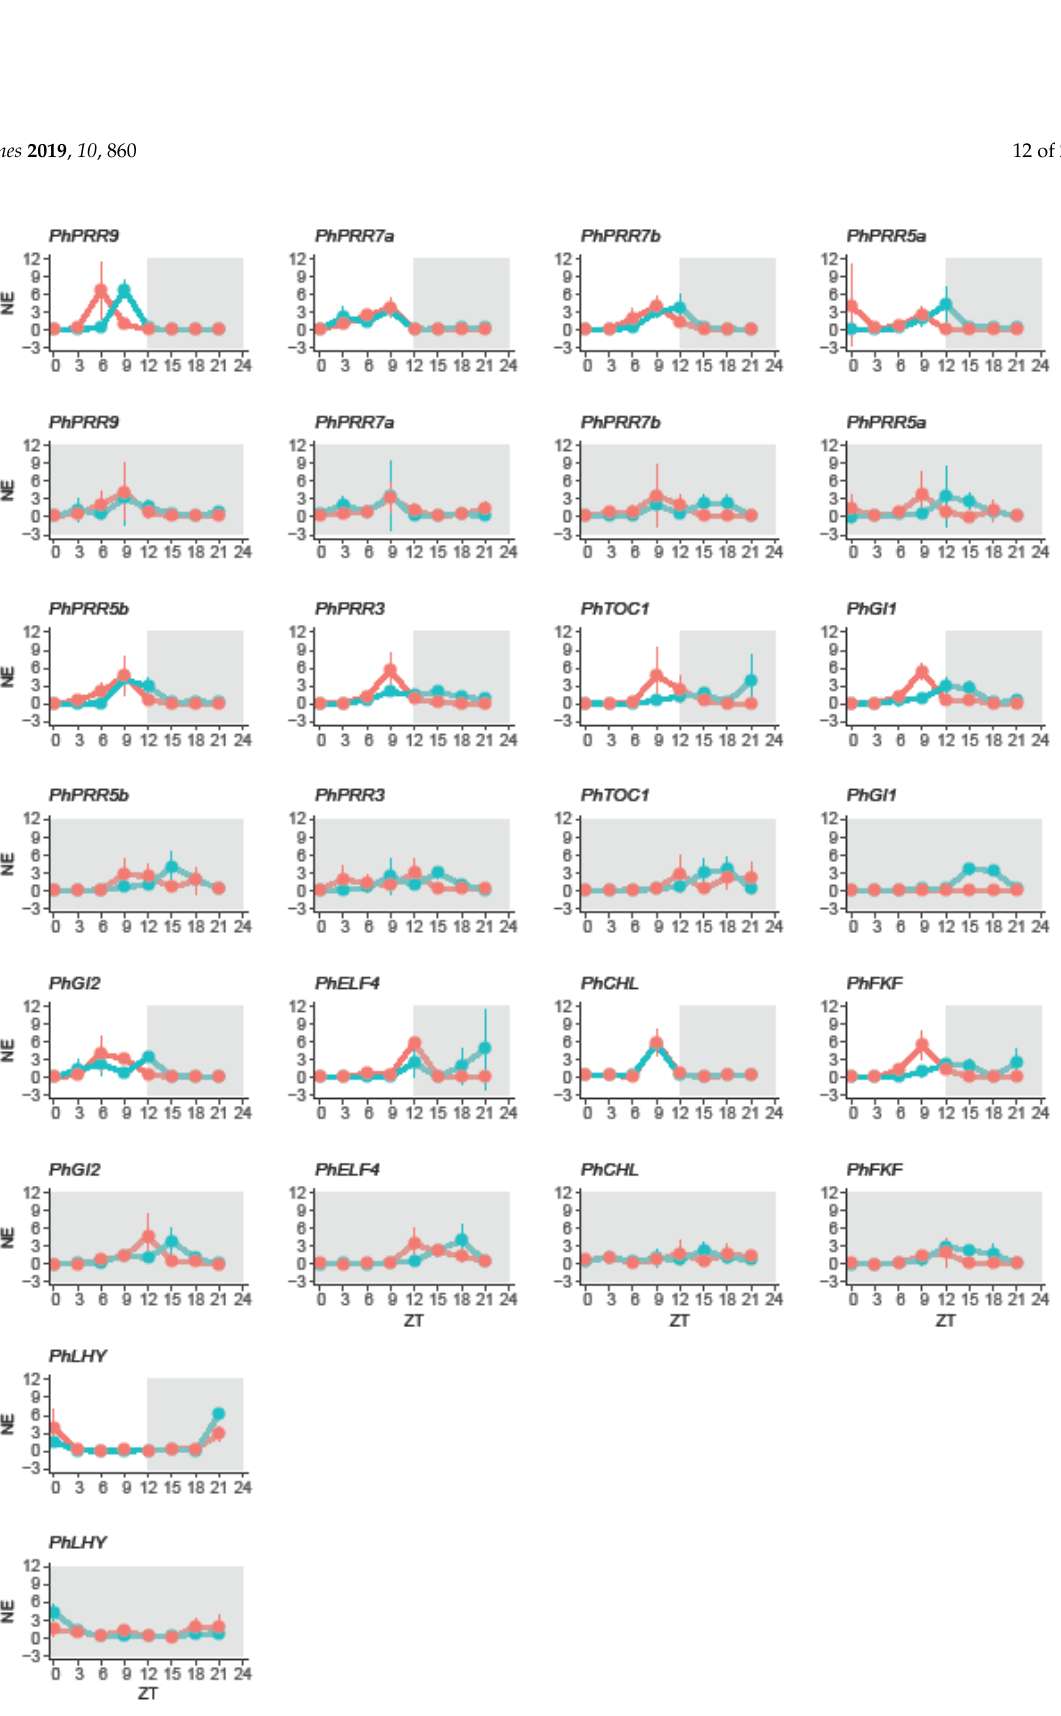
Figure 4. Daily changes in gene expression in petunia. Expression of clock genes in leaves (red) and petals (blue) under a 12 light:dark cycle (LD) and constant darkness (DD). LD cycle is represented by a white and grey area whereas DD cycle is represented by a dark area. Gene expression is represented as mean normalized expression (NE), first every clock gene was normalized to PhACT and then, for each time point the expression was divided by the mean expression level. ZT 0 (zeitgeber time) denoting light on, and ZT12, light o ff . Results represent mean ± SD ( n =